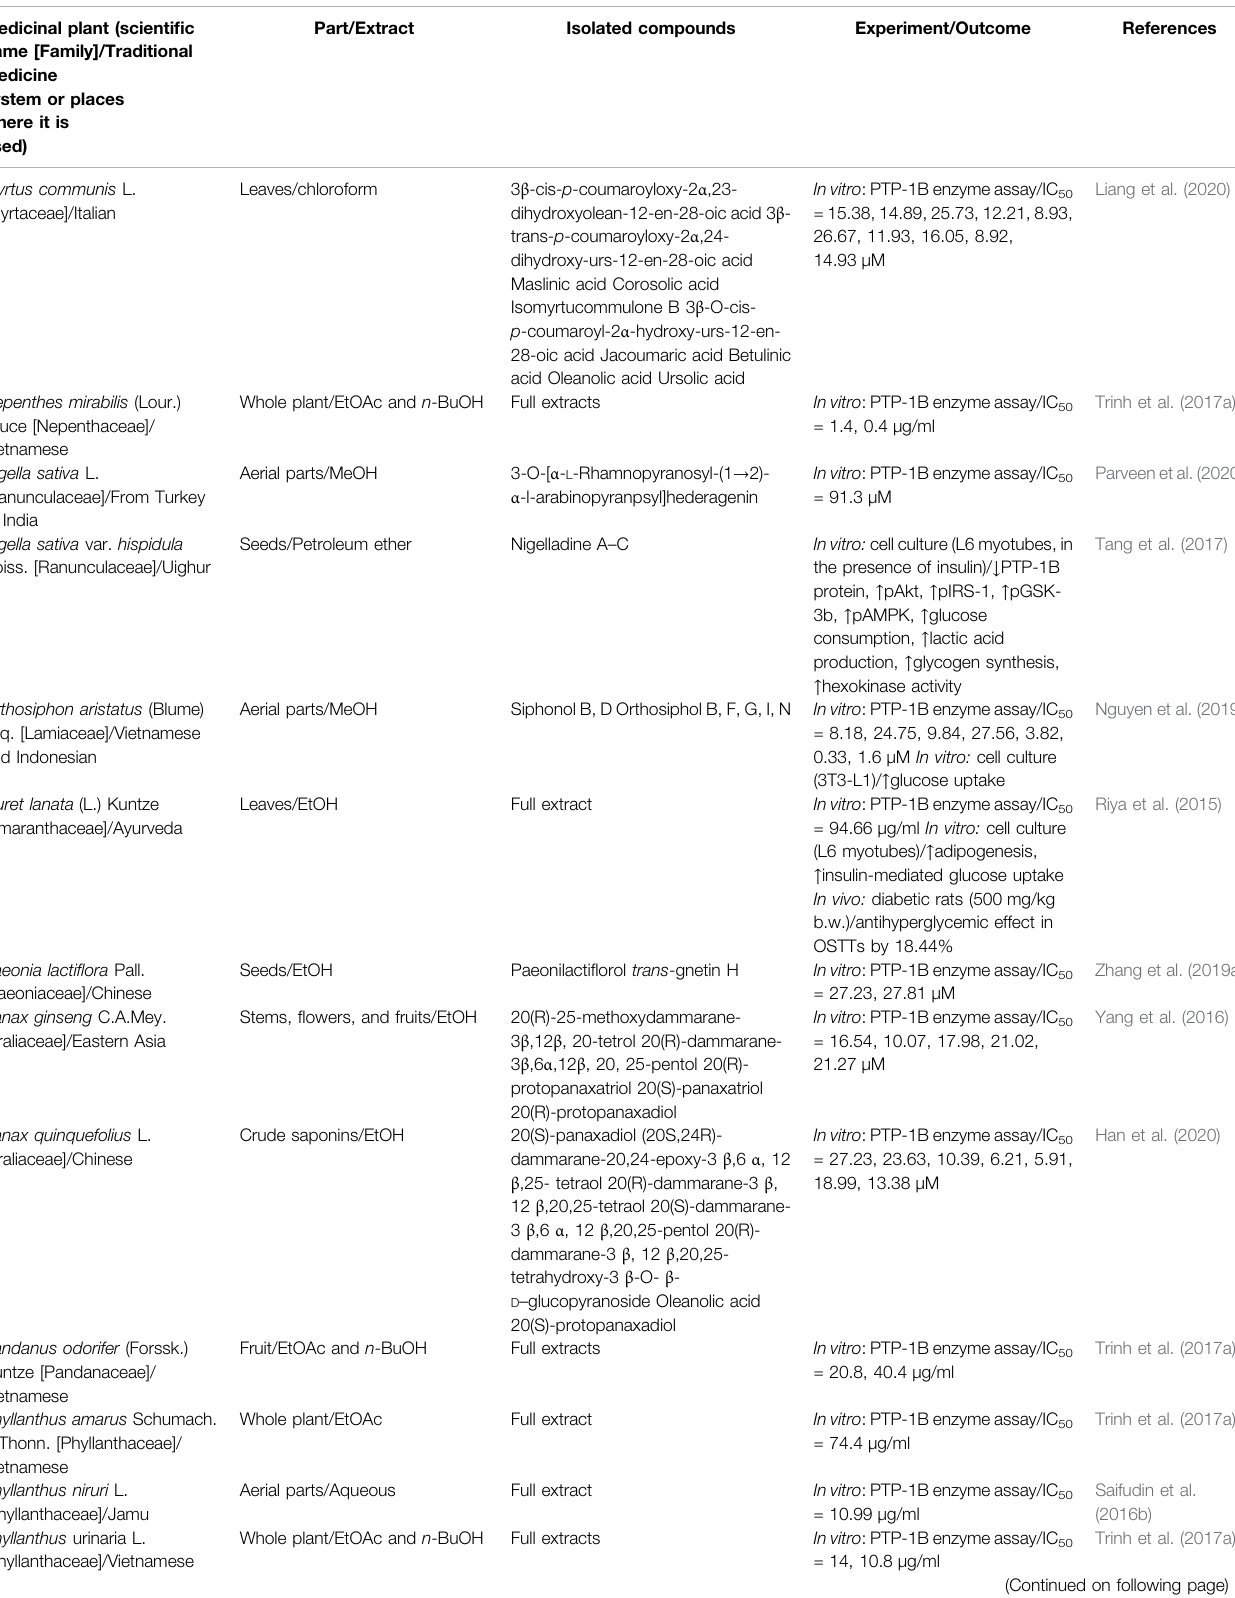
Medicinal plant (scienti fi c name